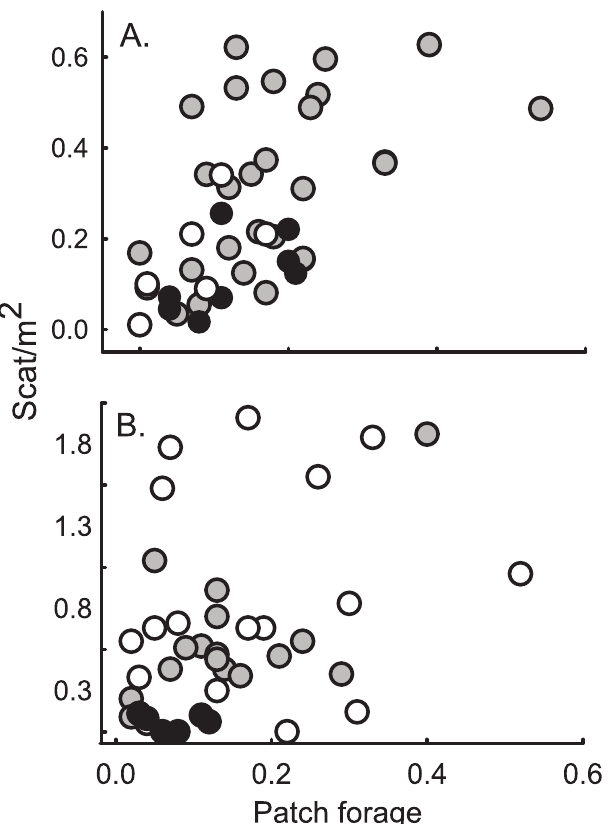
Fig 2. American pika scat density as a function of forage availability across elevation. Scat/m 2 in the Wind River (a; n = 43 sites) and Bighorn (b; n = 40) ranges in Wyoming, USA, 2010 and 2011, respectively. Elevation ranges are: < 3100m (white), > 3100 and < 3600m (gray), > 3600m (black); n = 43 sites.